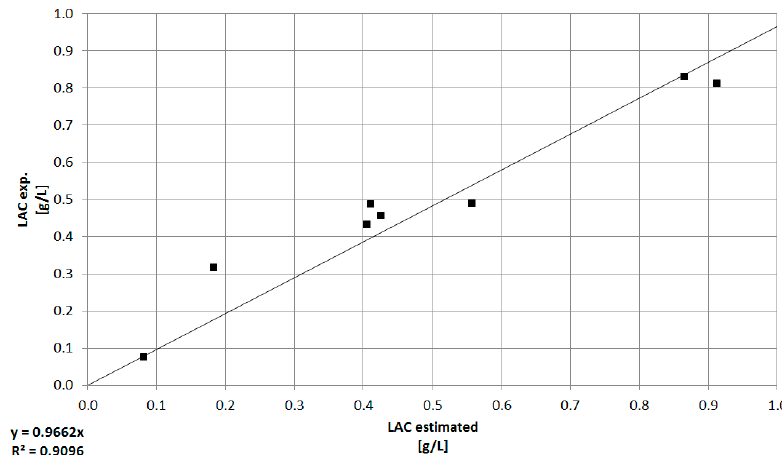
Figure 12. Comparison between offline measurements (exp) and model-based prediction of the lactate concentration. The deviation represents the offline double determination of the lactate concentration. The coefficient of determination for this relation is ≥